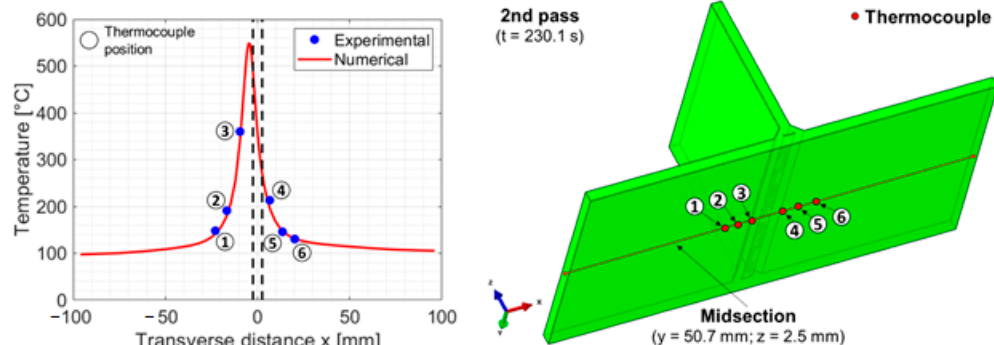
Figure 12. Experimental vs. numerical transverse temperature distributions in the flange in midsection ( y = 50.7 mm and z = 2.5 mm) at time t = 230.1 s during the second welding pass.